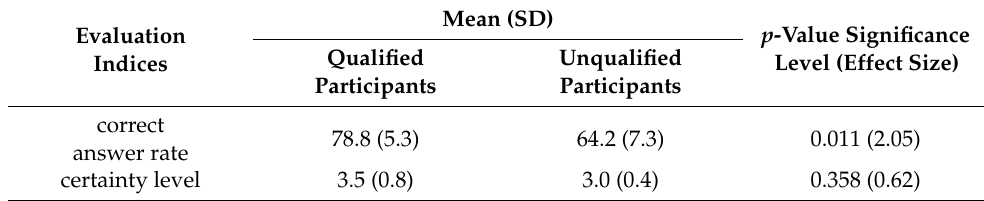
Figure 7. Correct answer rates ( a ) and levels of certainty ( b ). Table 5. t -test with a significance level of 5% to confirm the differences between teachers’ and beginning learners’ correct answer rate and certainty